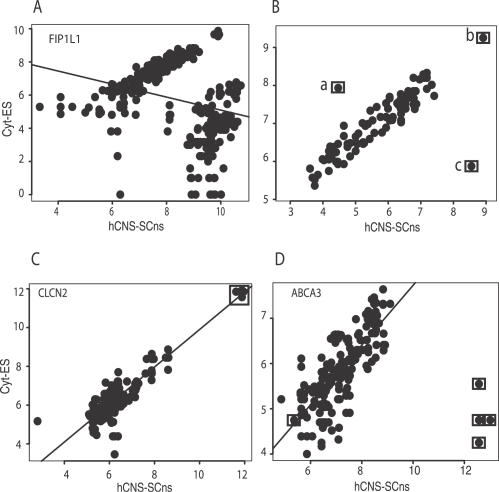
Sources of False Positives(A) Scatter plot of points for the FIP1L1 gene and the line representing the robust regression estimate.(B) Boxed point “a” represents a significant “outlier” (with a significantly different studentized residual and low leverage). Boxed point “b” represents a “high leverage” point (low studentized residual and a high leverage). Boxed point “c” represents a “high influence” point (high studentized residual, high leverage, and high influence).(C) Scatter plot of points for the CLCN2 gene. Boxed points represent “high leverage” points.(D) Scatter plot of points for the ABCA3 gene. Boxed points represent “high influence” points.